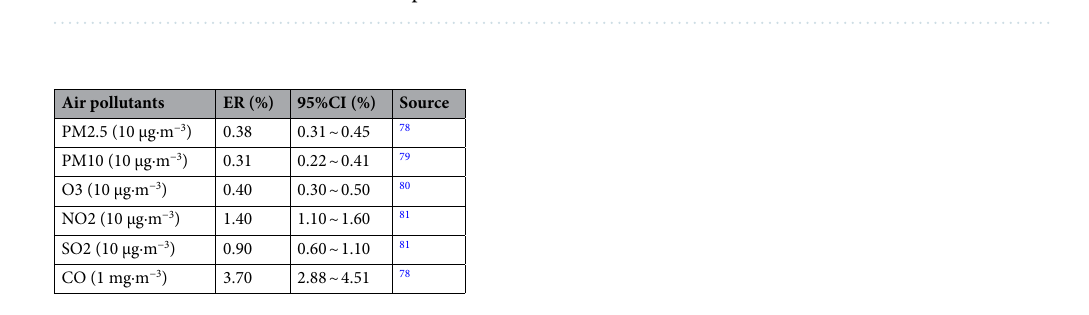
Table 6. Reference levels of various air pollutants.